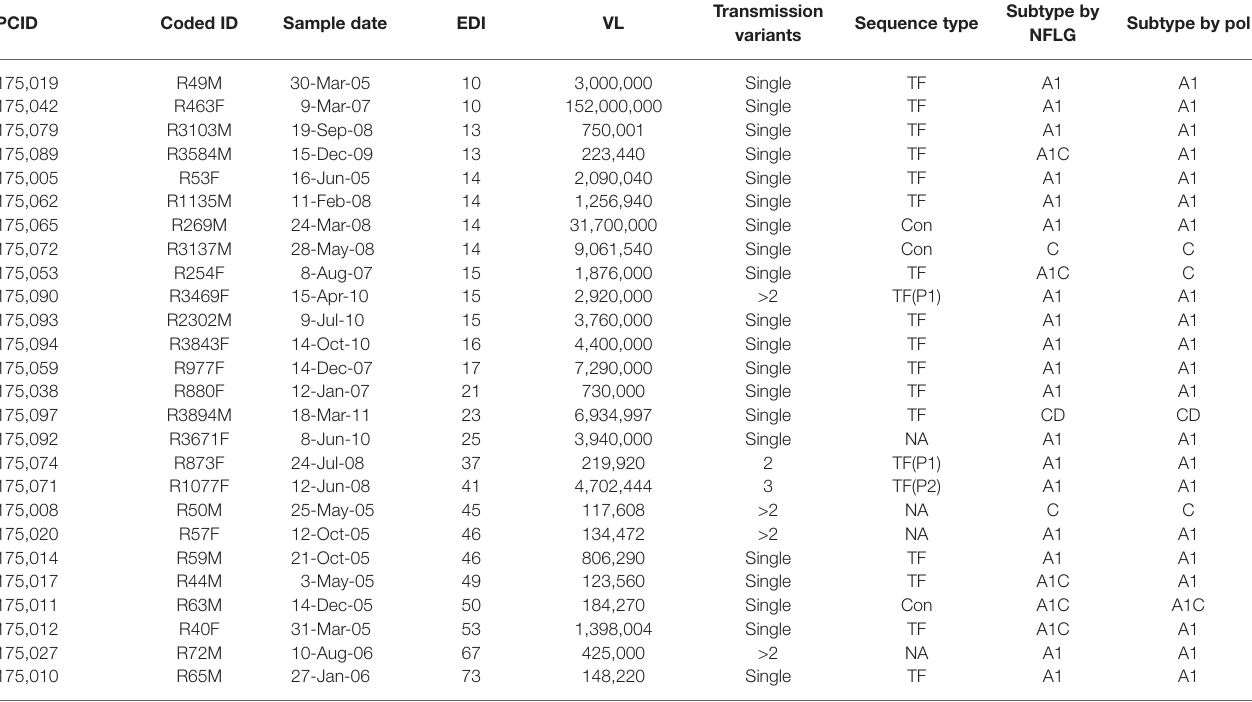
TABLE 2 | Transmission variants and subtypes in protocol C